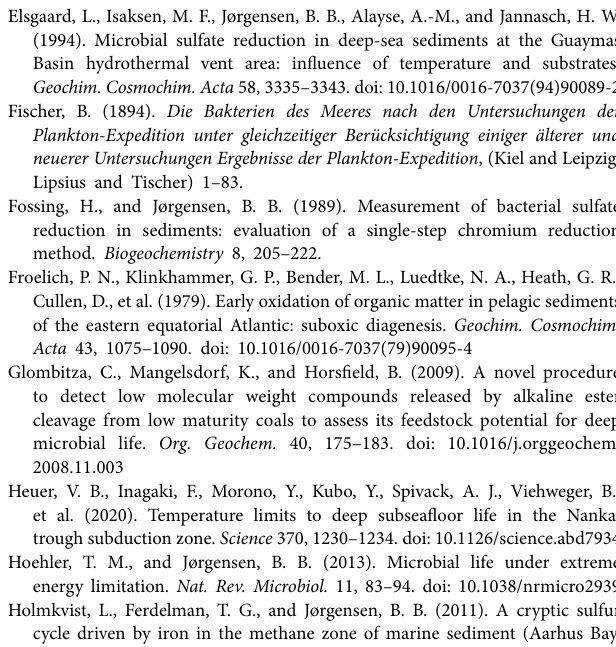
Supplementary Table S1 | List of all sulfate reduction rate